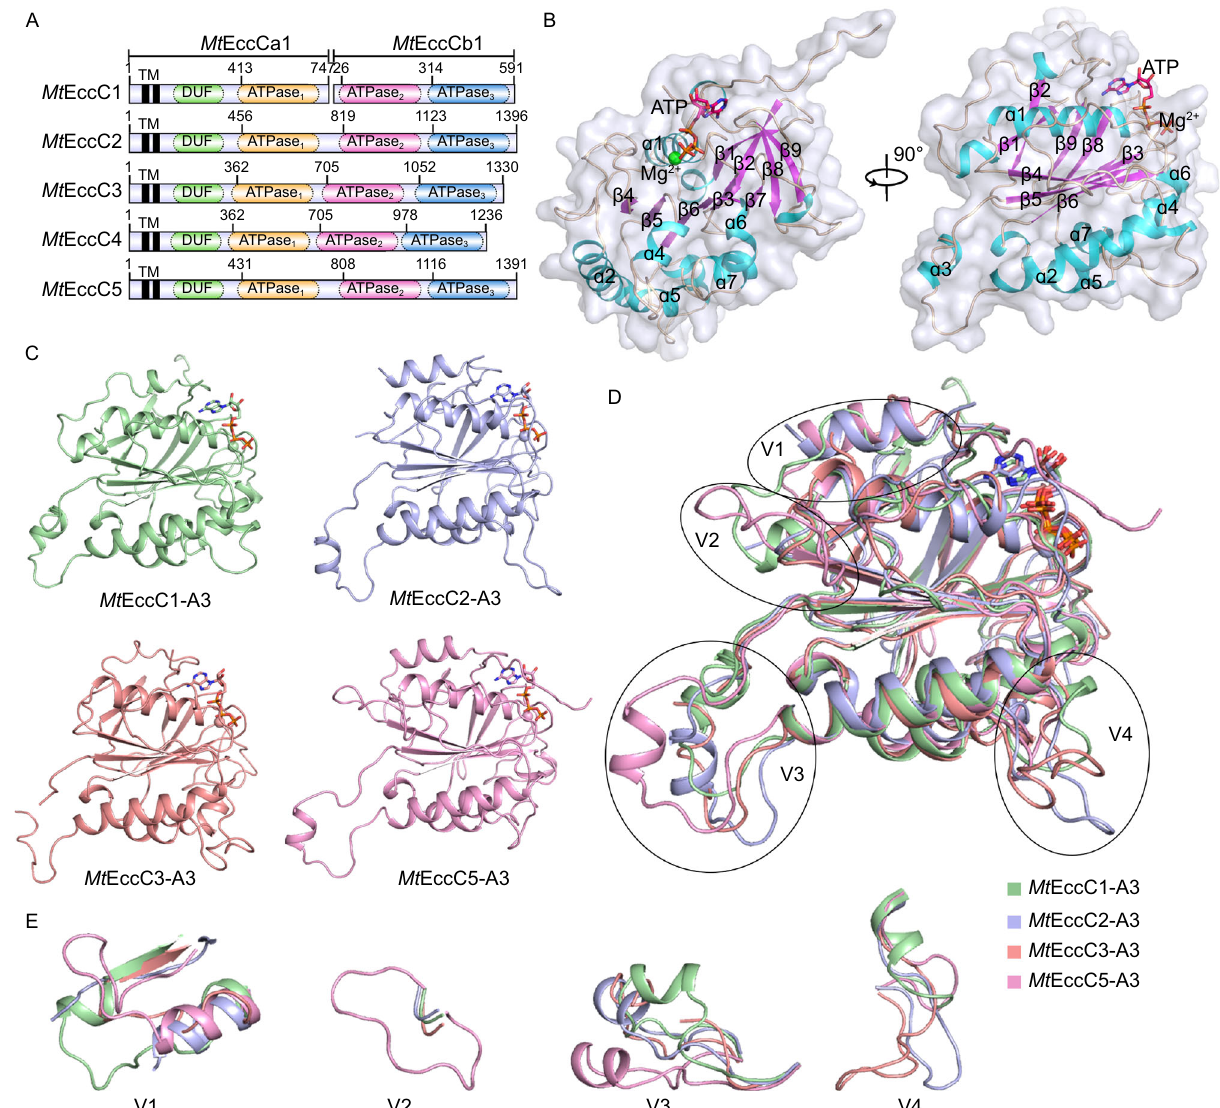
Figure 1. Overall structure of Mt EccC-ATPase 3 . (A) Domain arrangements of EccC proteins from Mycobacterium tuberculosis . (B) Cartoon and surface representation for Mt EccCb1-ATPase 3 . The helices and beta-sheets are colored cyan and magenta, respectively. ATP and the magnesium ion, are shown in stick representation and as a sphere, respectively. (C) Cartoon representation of Mt EccCb1-ATPase 3 (C1A3, pale green), Mt EccC2-ATPase 3 (C2A3, light blue), Mt EccC3-ATPase 3 (C3A3, salmon) and Mt EccC5-ATPase 3 (C5A3, pink). (D) Superposition of the four structures in (C). Structures of the four variable regions (V1 – V4) are marked with circles. (E) Close-up views of the four variable regions in